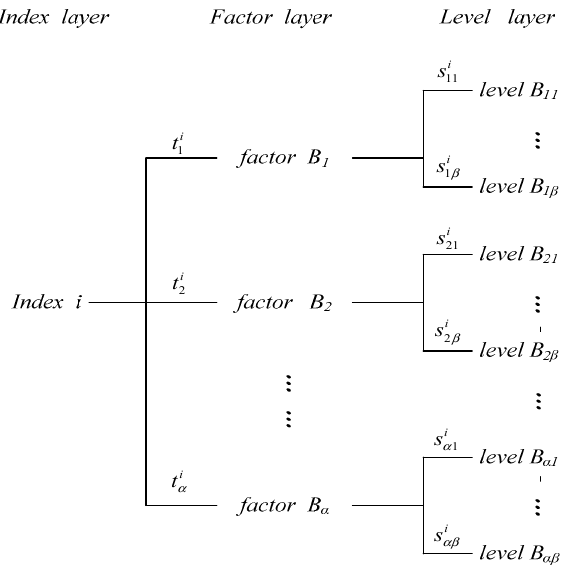
Figure 3. Hierarchical structure model of factors and levels for the i -th index.